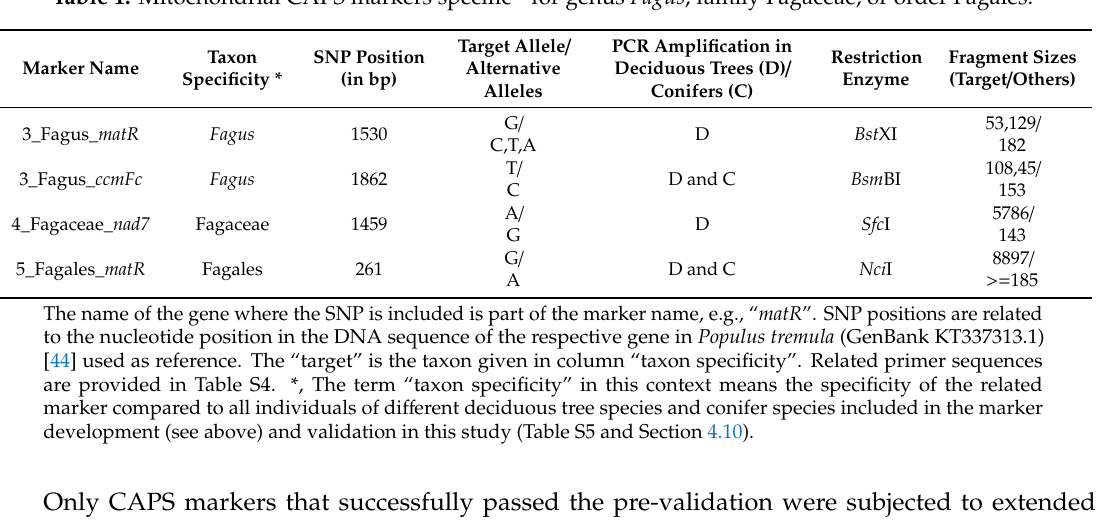
Table 1. Mitochondrial CAPS markers specific * for genus Fagus , family Fagaceae, or order